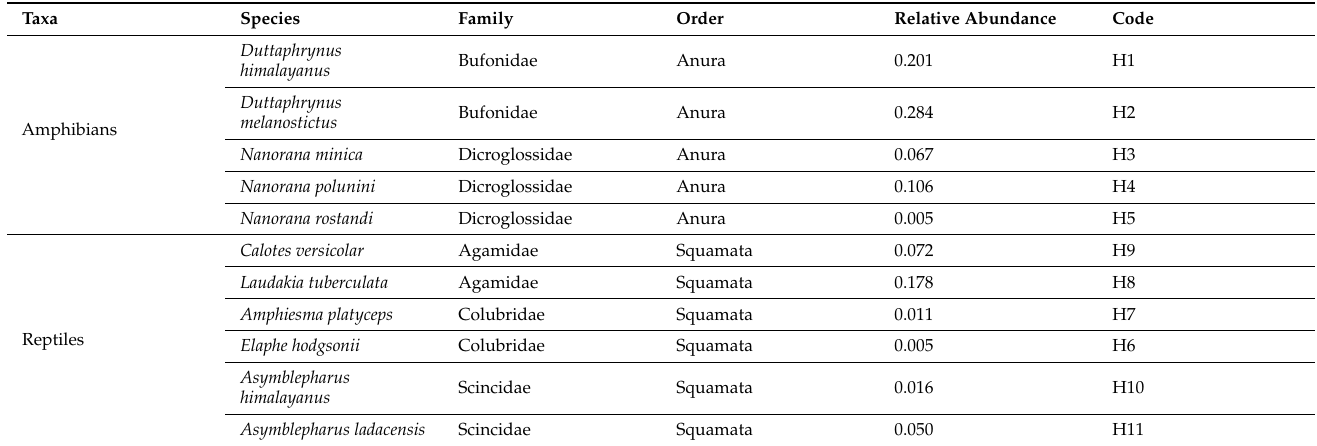
Table 4. List of herpetofaunal species recorded in the RWC with their relative abundance and species code used for redundancy